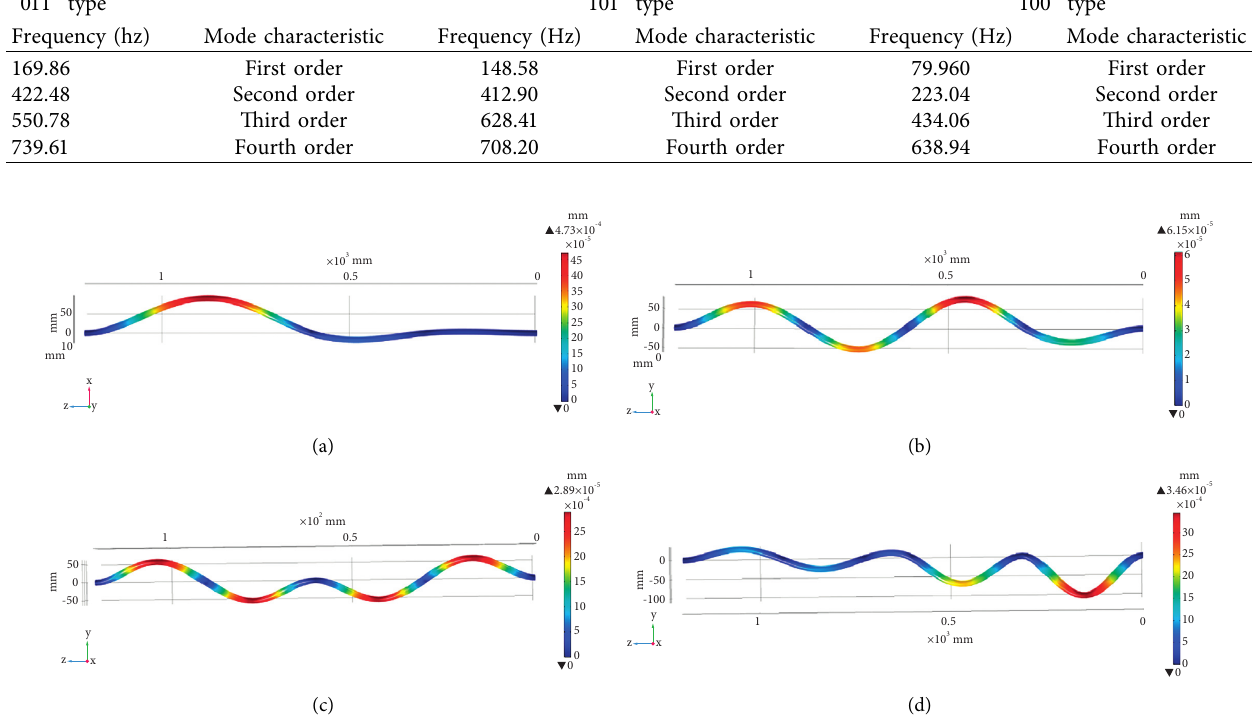
Figure 5: “011” mode. (a) First order. (b) Second order. (c) Third order. (d) Fourth order.